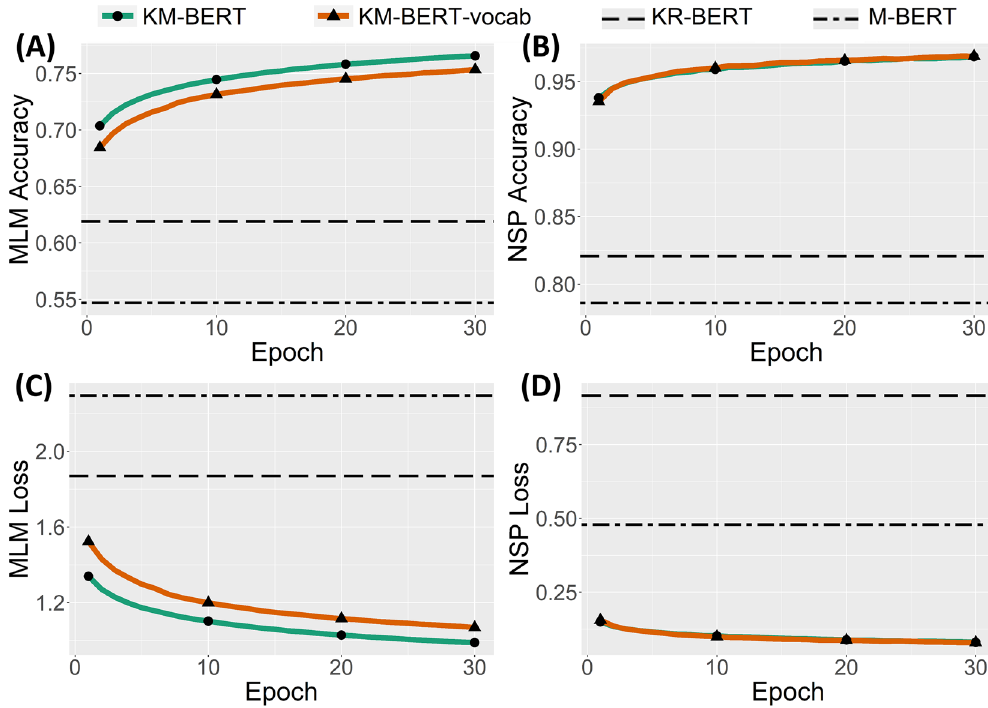
Figure 2. Pre-training results of KM-BERT and KM-BERT-vocab for MLM and NSP tasks over epoch. Dashed line representing KR-BERT and dot-dashed line representing M-BERT denotes the performance of the final pre-